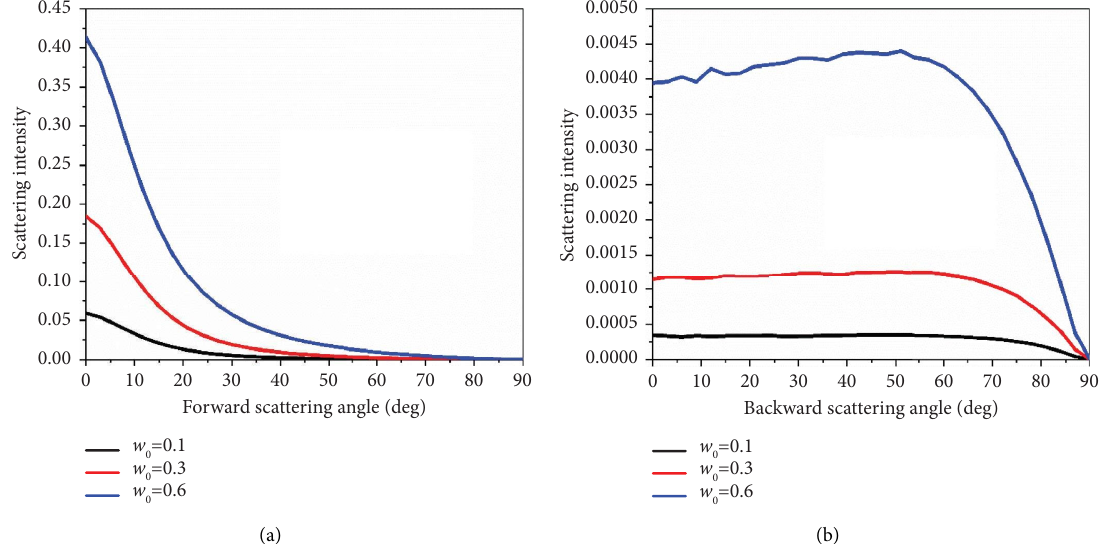
Figure 5: Te scattering intensity versus scattering angle for diferent albedo.